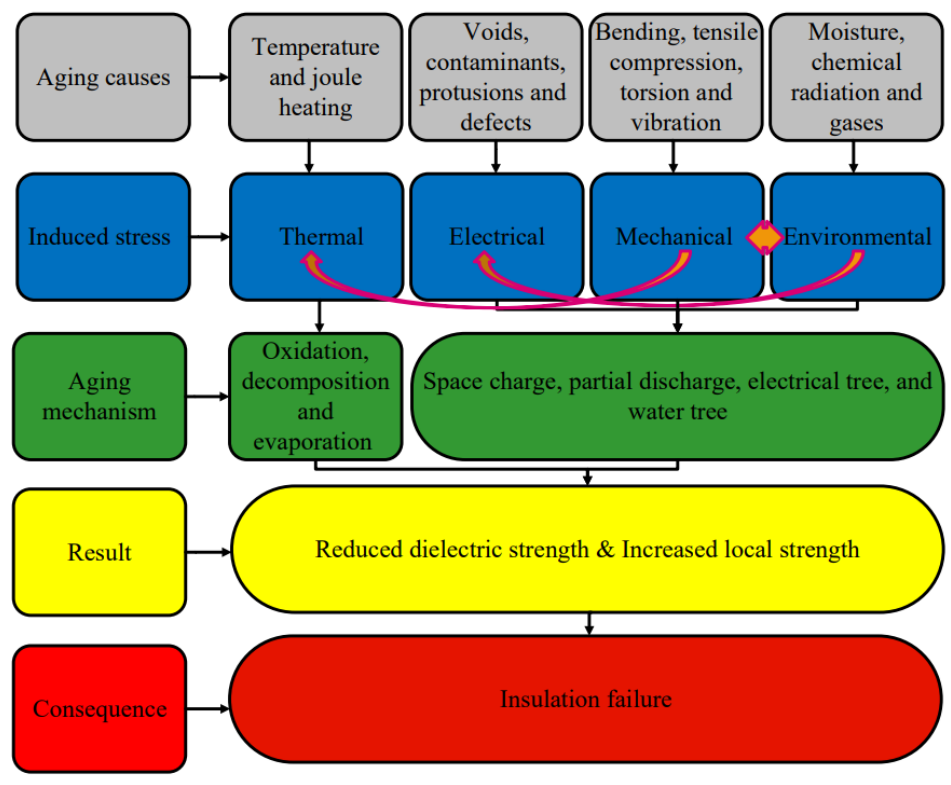
Figure 1. Aging factors, causes, mechanisms, effects, and consequences for solid insulation. Considering underground cables as a critical component of the medium-voltage (MV) grid having dielectric a major part of its physical design, typical insulation defects are depicted in Figure 2. The most alarming defects lie within the main insulation between shielding and the conductor